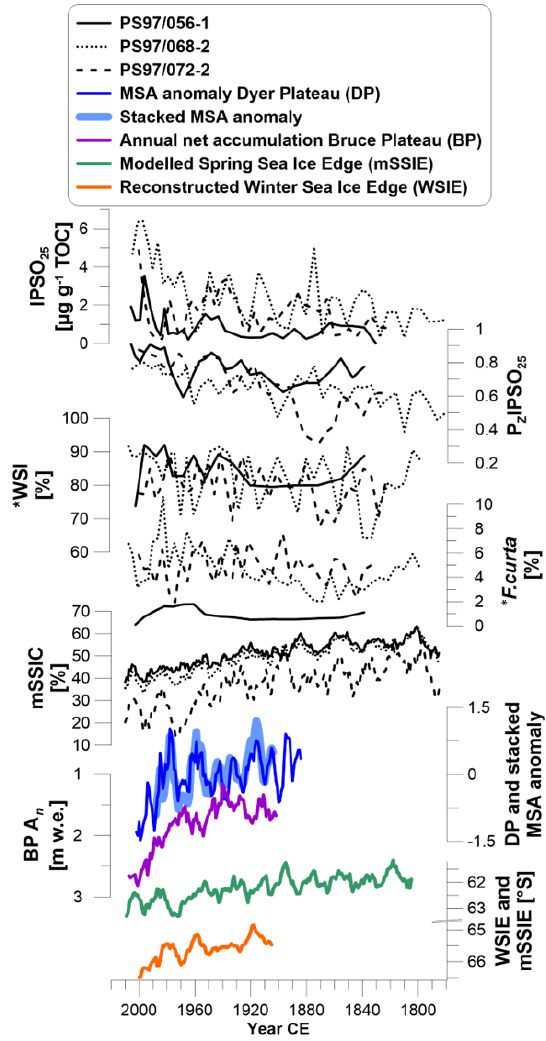
Figure 5. The biomarker (from top to bottom) IPSO 25 , sea ice in- dex P Z IPSO 25 , winter sea ice concentration (WSI) from diatom as- semblages and abundance of F. curta compared to modeled spring sea ice cover (mSSIC; 10-year running mean), MSA anomaly from Dyer Plateau, stacked MSA covering the Bellingshausen Sea sec- tor (5-year running mean; Abram et al., 2010), annual net accu- mulation from Bruce Plateau (5-year running mean; Goodwin et al., 2016), modeled spring sea ice edge latitude (mSSIE; 10-year running mean) and reconstructed winter sea ice edge latitude from MSA (WSIE; 10-year running mean; Abram et al., 2010). Data marked with * are from the trigger core